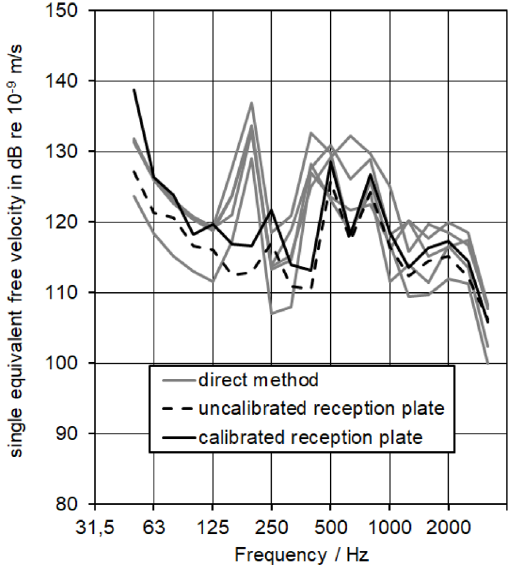
Figure 16. Measured single equivalent free velocity levels for the round robin reference source.